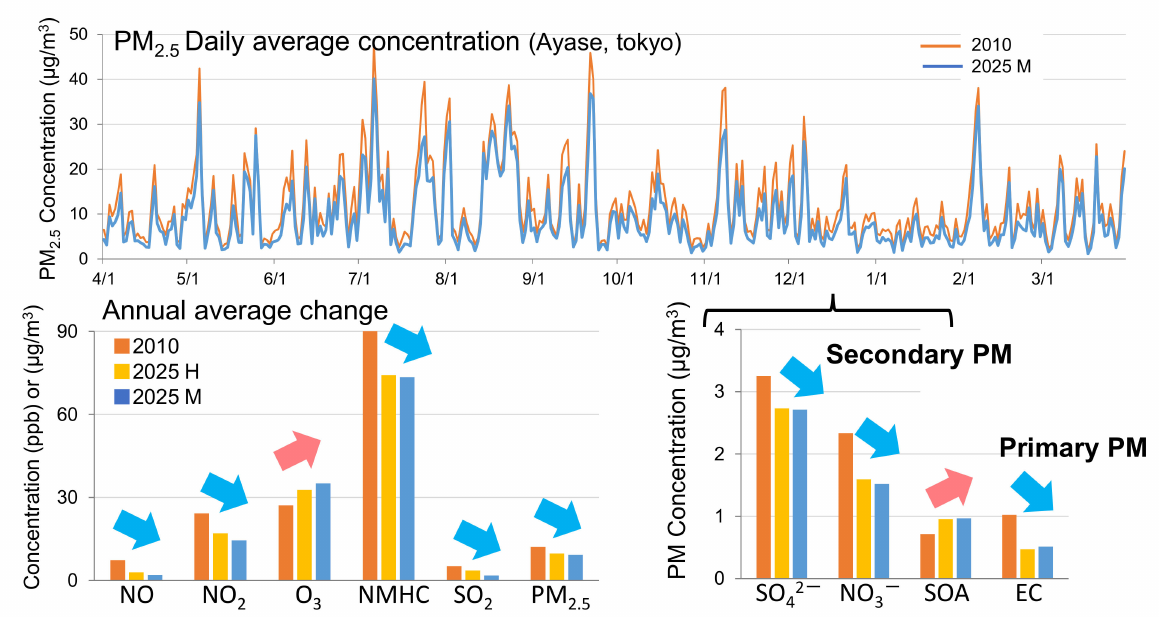
Figure 14. Future air quality prediction results for fiscal year 2025. The concentrations of NOx, SO 2 , and NMHC, which are PM 2.5 precursors, are lower, and the concentration of PM 2.5 is also slightly lower. On the other hand, the O 3 /SOA concentration of the secondary substances is higher, but the sulfate nitrate is